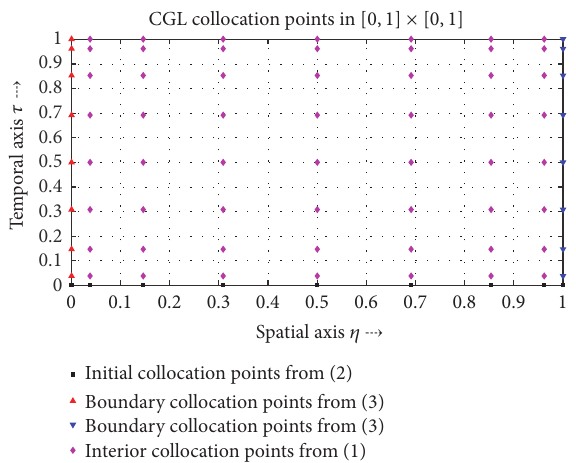
Figure 1: CGL collocation points in the unit square for 𝑁 = 8 for 1D diffusion